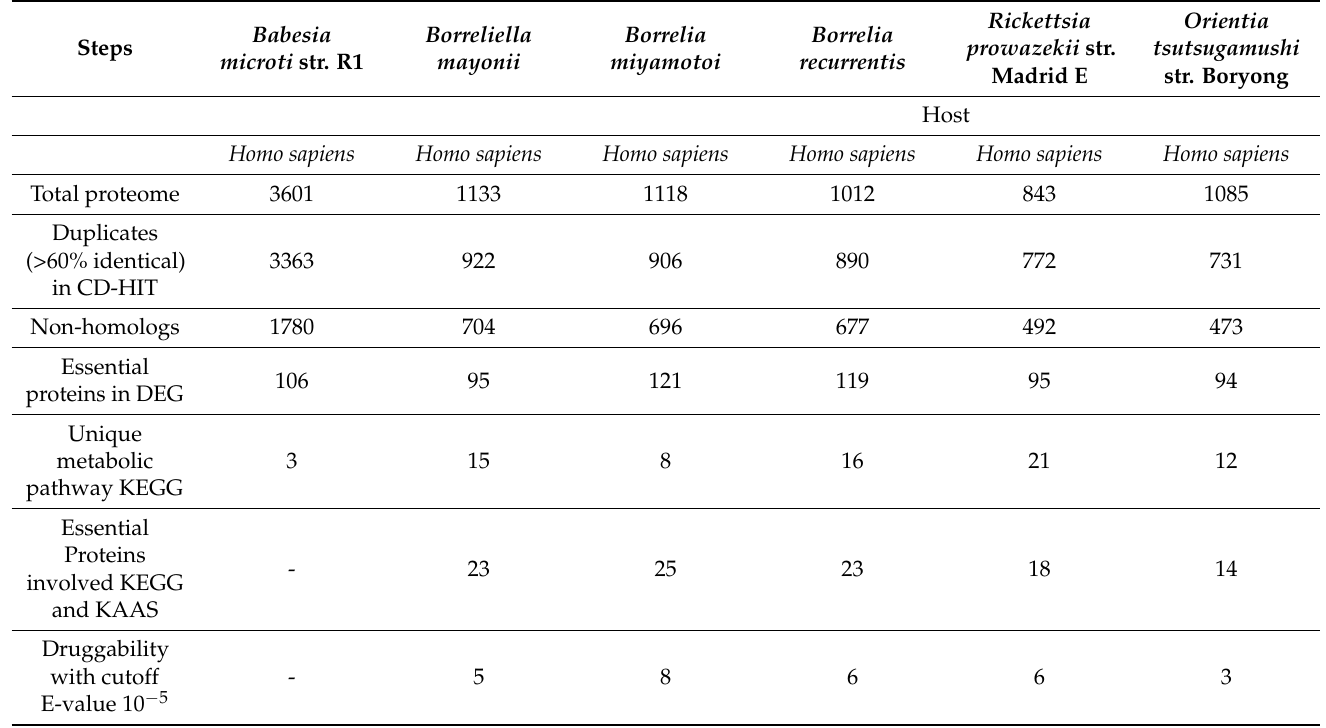
Table 2. Subtractive proteome analysis and metabolic pathway results of lice, acari, and their associated